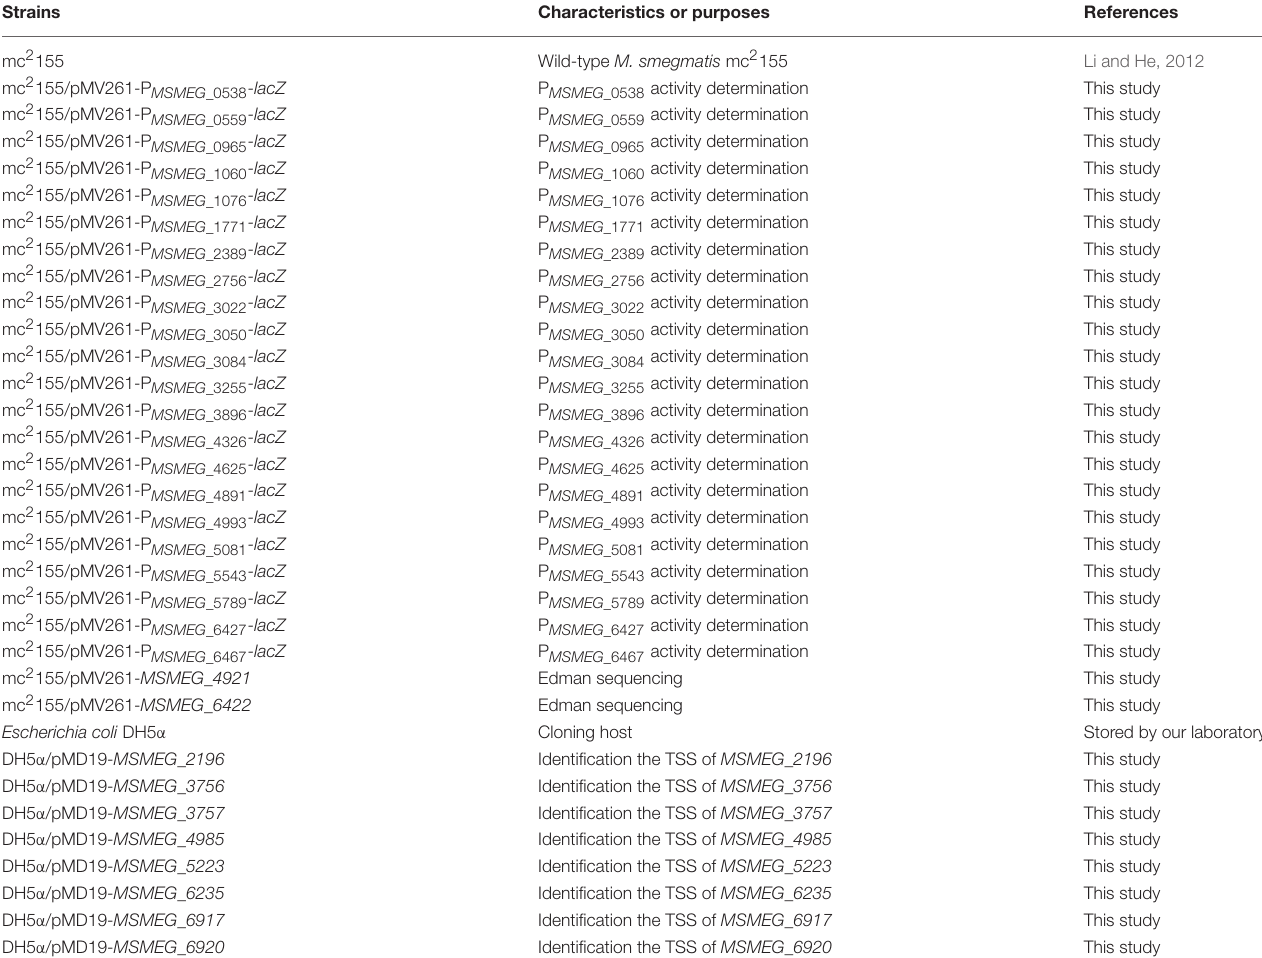
TABLE 1 | Strains used in this